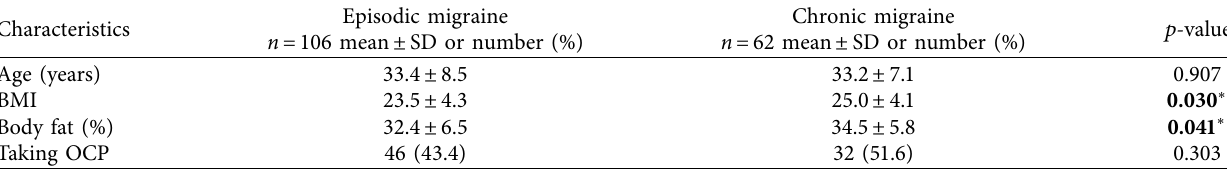
Table 1: Depicts the association of age, BMI, high fat mass, and OCP use with chronic migraine. Characteristics